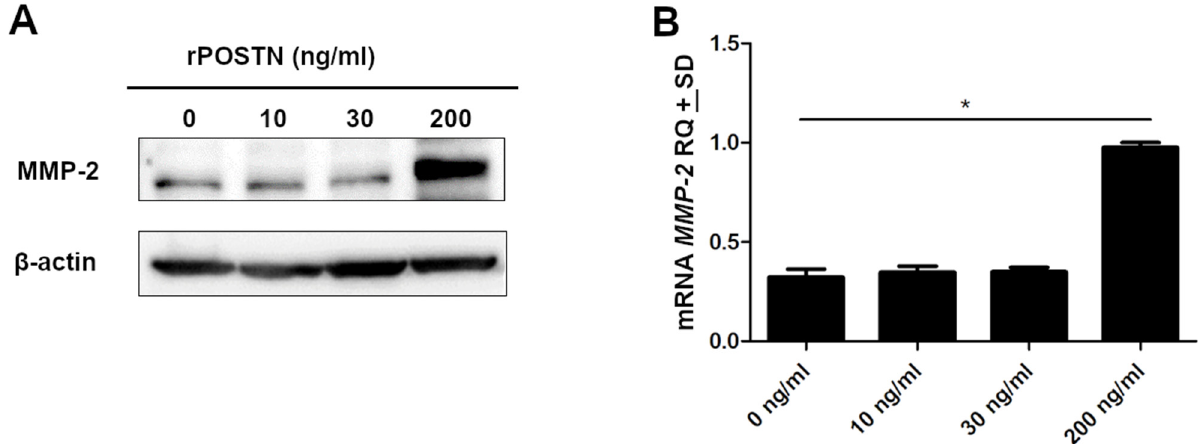
Figure 13. Effects of increased periostin (POSTN) on MMP-2 expression. A549 cells were cultured in the serum-free medium for 12 h, followed by treatment with various concentrations of recombinant POSTN (rPOSTN) for a further 12 h. ( A ) MMP-2 expression was determined by Western blot analysis. β -actin served as an internal loading control. ( B ) MMP-2 mRNA expression level was analyzed by real-time PCR (* p < 0.05). RQ, relative quantification.